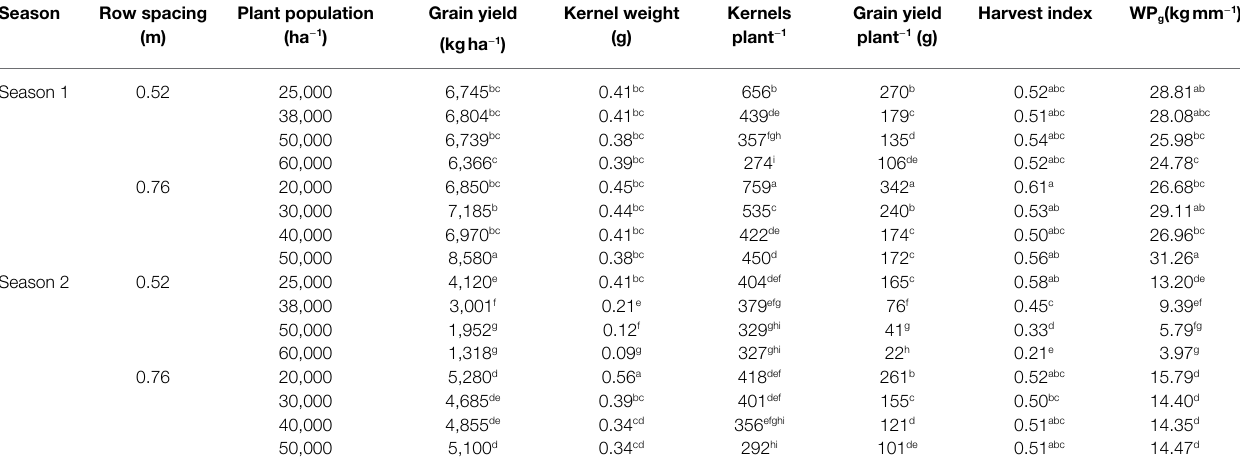
TABLE 5 | Effect of row spacing and plant population on grain yield, kernel weight, kernels per plant, grain yield per plant, and harvest index in Seasons 1 and 2. Season